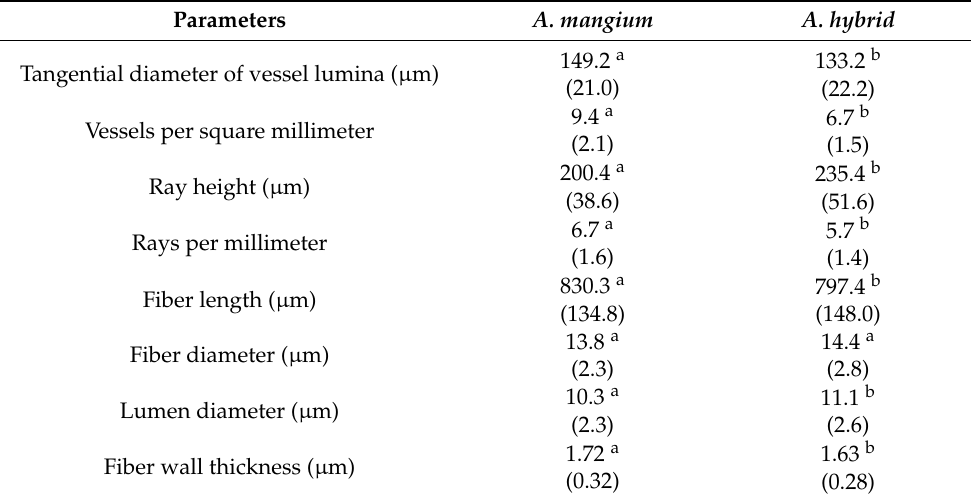
Table 3. Quantitative anatomical characteristics of A. mangium and A. hybrid . Parameters A. mangium A.